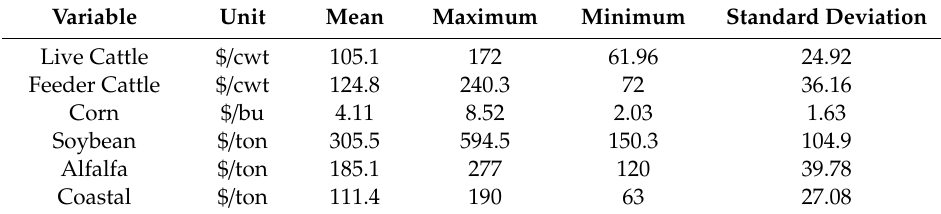
Table 2. Summary of statistics for Texas cash prices from 2002 to 2017.